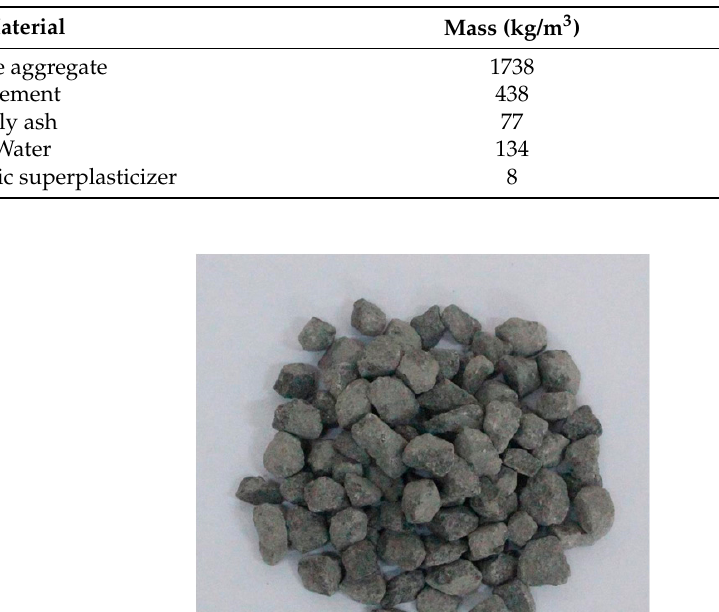
Table 1. Concrete mix proportions.